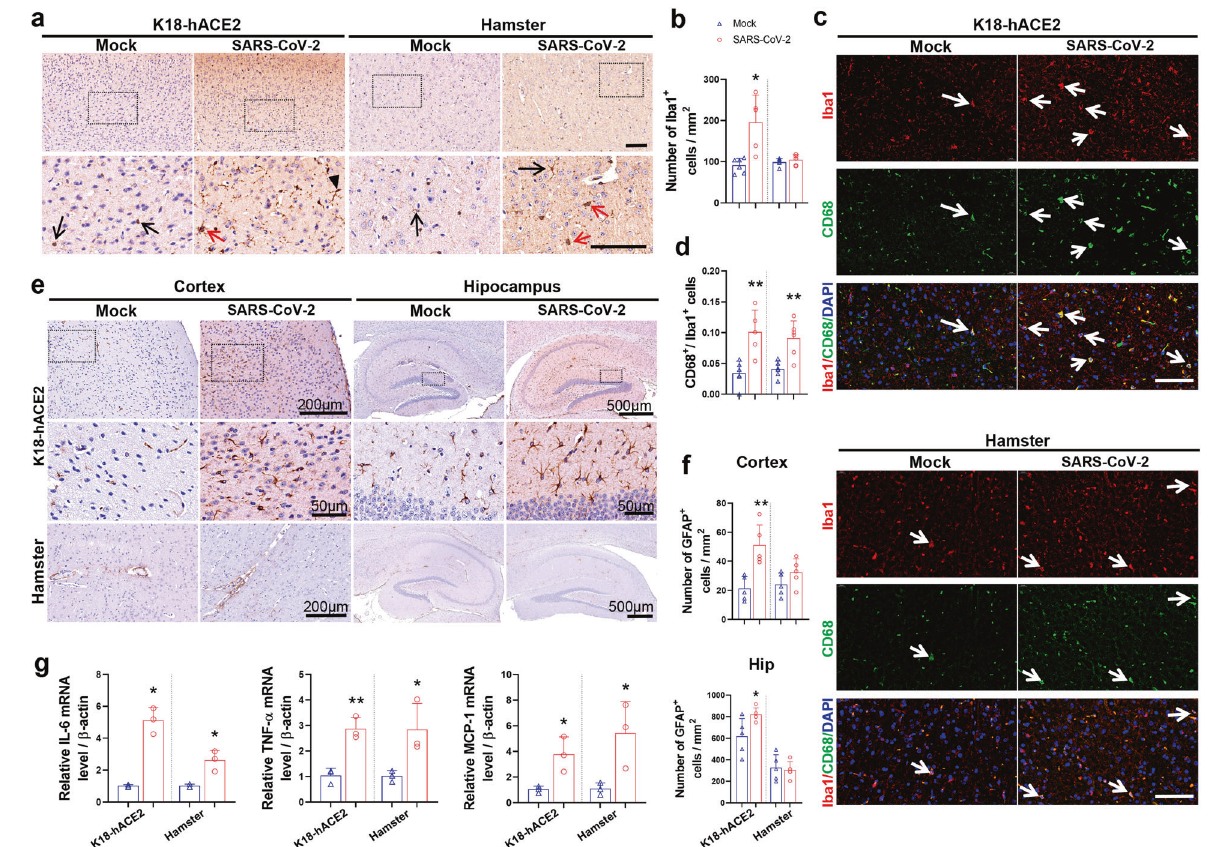
Fig. 2 Activation of glial cells in SARS-CoV-2-infected animal models. a Representative images showing IHC staining for Iba1, a marker for microglia in the cortex of infected K18-hACE2 mice and hamsters. Black arrow: unactivated microglia; red arrow: M1 microglia; black arrowhead: M2 microglia. b Semi-quantitative analysis of microglial cells in the cortex of infected K18-hACE2 mice and hamsters. c Representative images showing co-localization of Iba1 and CD68 (a marker for M1 microglia) in the cortex of infected hamsters. d The proportion of Iba1 and CD68 double-positive microglia in the cortex of animal models. e Representative images showing IHC staining for GFAP, a marker for activated astrocytes in the cortex and hippocampus of infected animal models. f Semi-quantitative analysis of GFAP + astrocytes. N = 5 – 8 slices from three animals per group. g Relative mRNA levels of in fl ammatory factors in the brains of animal models ( n = 3/ group). The p -values were determined by a two-tailed unpaired Students ’ t -test. * p < 0.01,** p < 0.01, vs. mock-treated group, respectively. Scale bars: a 100 μ m; c 50 μ